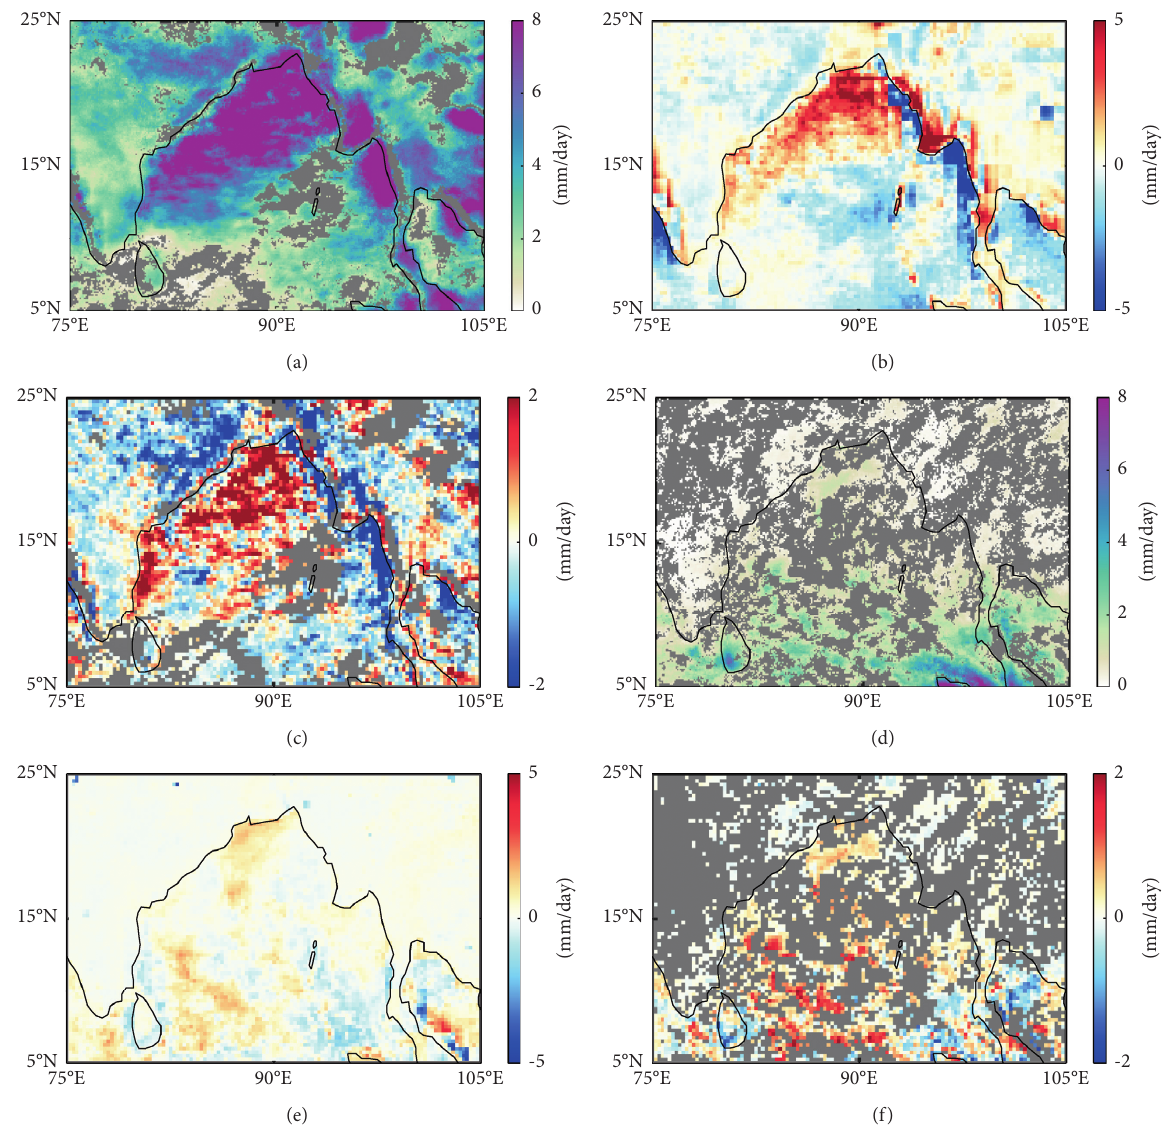
Figure 10: Amplitudes of the diurnal cycles in the IMERG data, differences between mean precipitation, and differences between mean precipitation diurnal amplitude in the IMERG V06B and TMPA 3B42 data in (a, c) JJA and (d, f) DJF. The grey areas indicate the diurnal harmonics were not statistically significant at the 90% confidence level. (a) Amplitude in IMERG (JJA). (b) Differences of mean precipitation (JJA). (c) Differences of amplitude (JJA). (d) Amplitude in IMERG (DJF). (e) Differences of mean precipitation (DJF). (f) Differences of amplitude